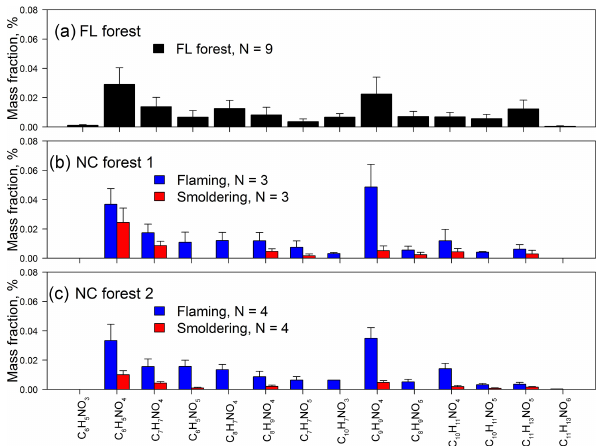
Figure 3. Relative mass contributions of identified N-containing aromatic compounds in BB samples collected during the (a) FL for- est, (b) NC forest 1, and (c) NC forest 2